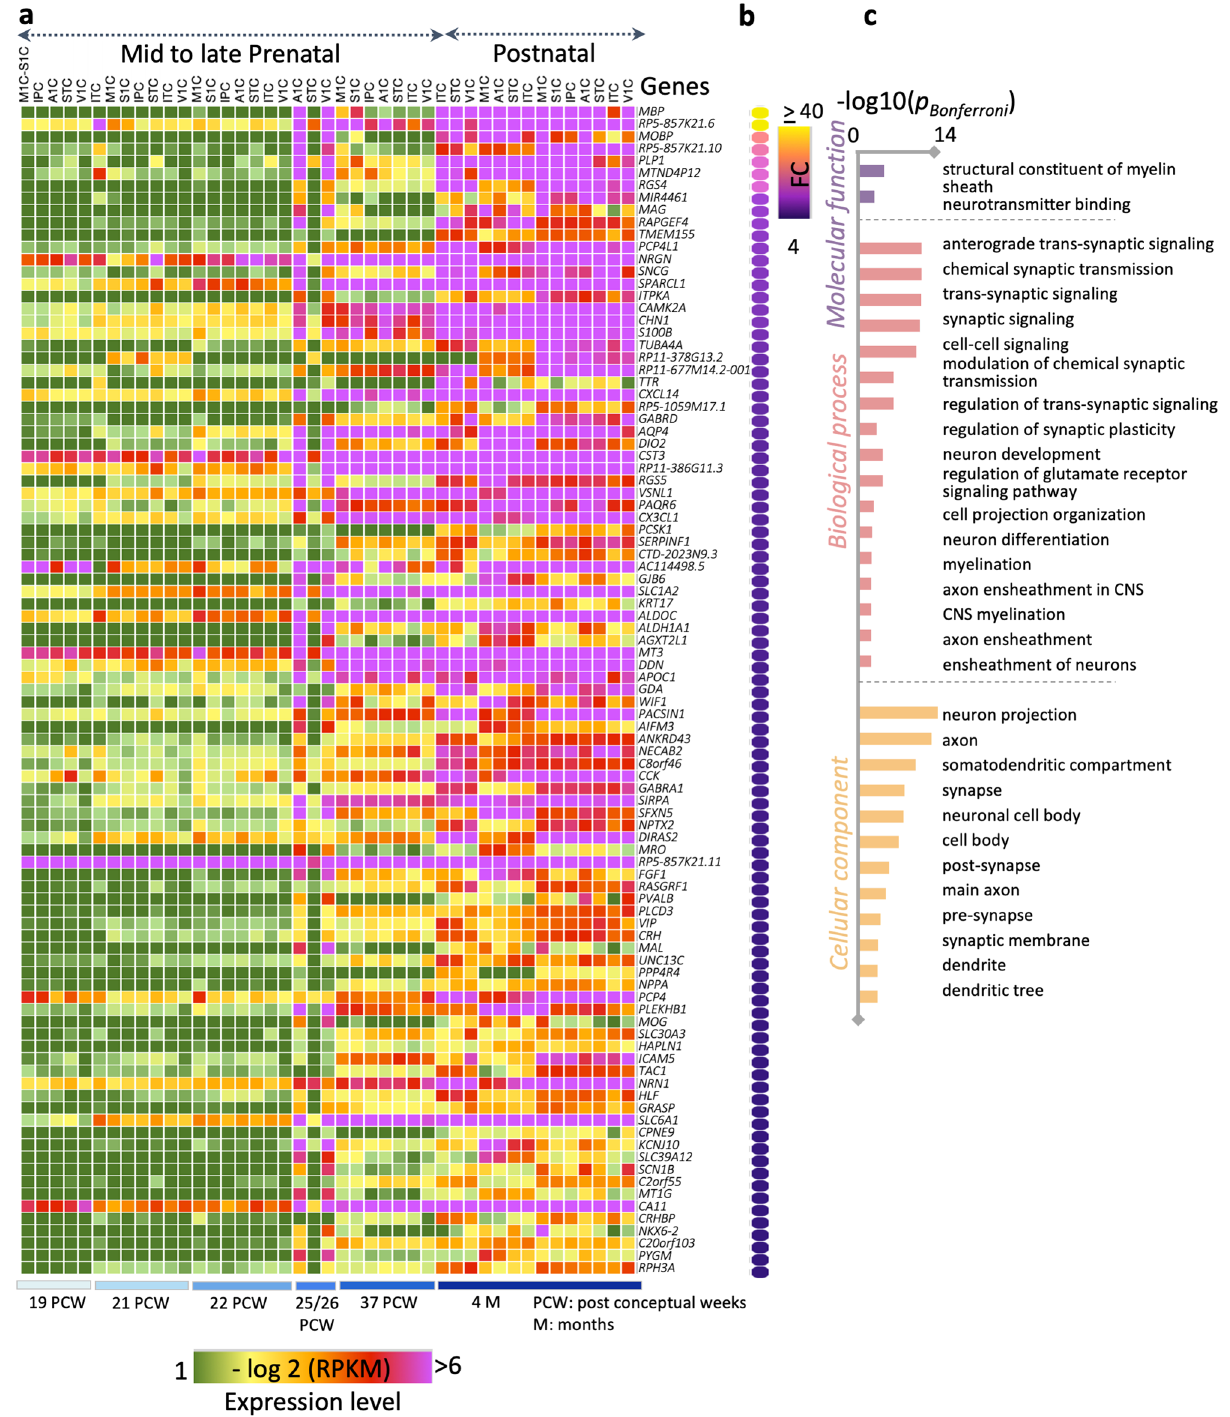
Fig. 3 Transcriptomic gene analysis of cortical samples reveals that myelination and synaptic processes are cellular mechanisms of postnatal development. a Matrix showing gene expression levels in prenatal (19 post conceptual weeks (pcw) to 37 pcw) and postnatal (4-months-old) cortical tissue samples for the 95 most differentially expressed genes. N prenatal tissue donors = 7; N postnatal tissue donors = 3. Sample demographics in Supplementary Table 6. Rows: genes, columns: cortical area (acronyms in Supplementary Table 7); color: expression level in reads per kilobase million (RPKM, see colorbar). b Gene expression fold change (FC) between postnatal vs. prenatal cortical samples of the 95 most differentially expressed genes. c Gene enrichment analysis showing the molecular and biological processes and cellular components related to these 95